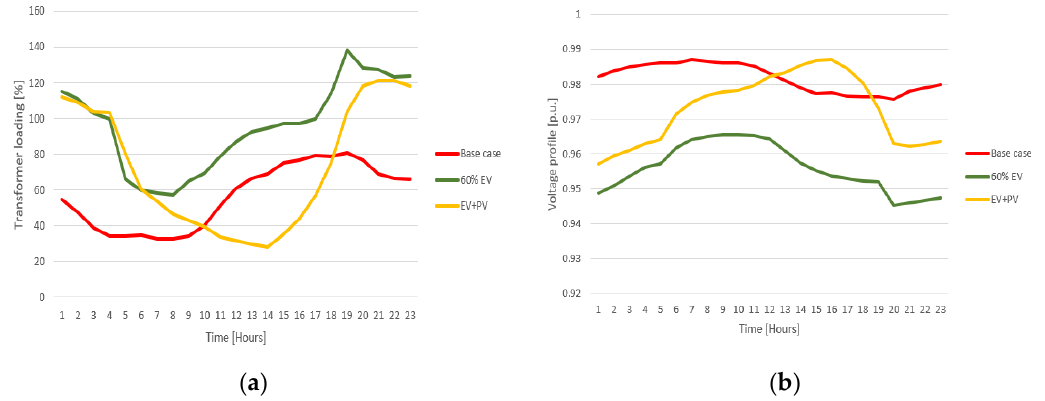
Figure 10. Comparison of urban ( a ) transformer loadings and ( b ) most loaded feeder voltage profiles with 60% EV penetration.